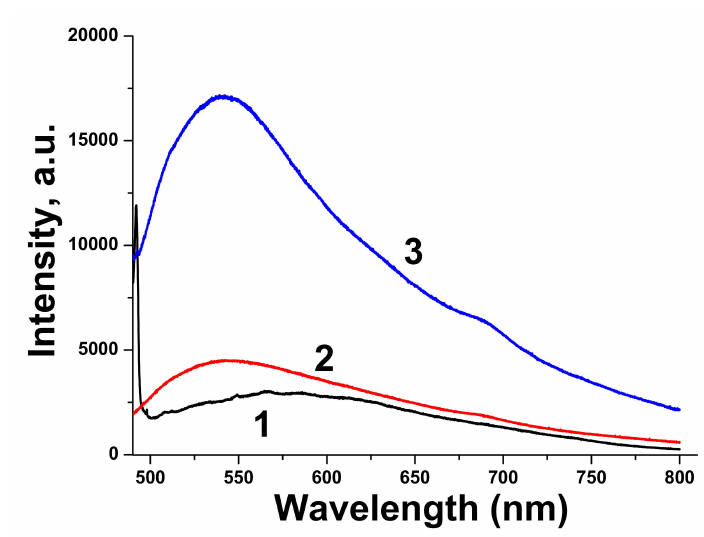
Figure 12. Luminescence spectra of BTO NPs ablated in H 2 O (1), Au-BTO NPs generated by laser ablation of Au target in aqueous solution of BTO NPs for 10 min (2), Au-BTO NPs generated by laser ablation of Au target in aqueous solution of BTO NPs for 15 min (corresponds to Figure 9) (3). Excitation wavelength of 473 nm.